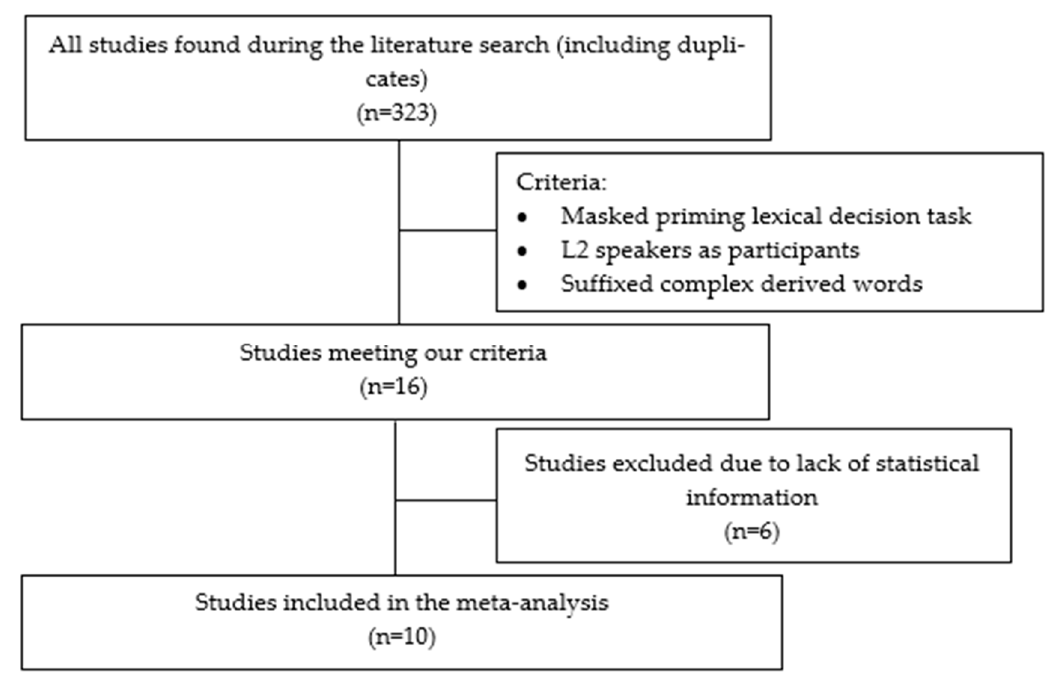
Figure 1. Flow chart of studies included in the meta-analysis.